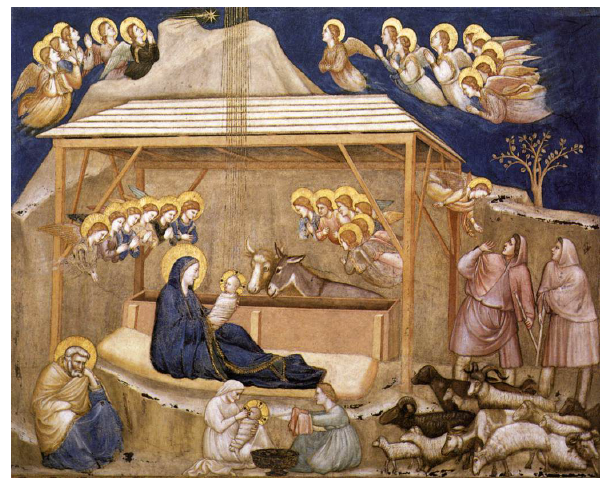
Figure 12. Nativity scene by Giotto, Lower Church, Assisi, Italy (ca. 1310). Source: public domain – Wiki Commons.